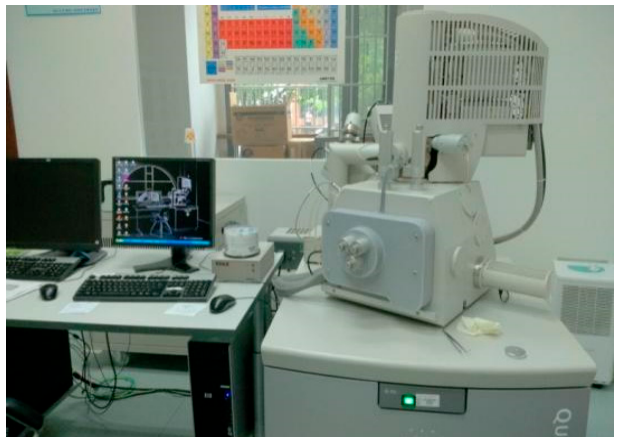
Figure 6. Spraying conductive material microscopy.